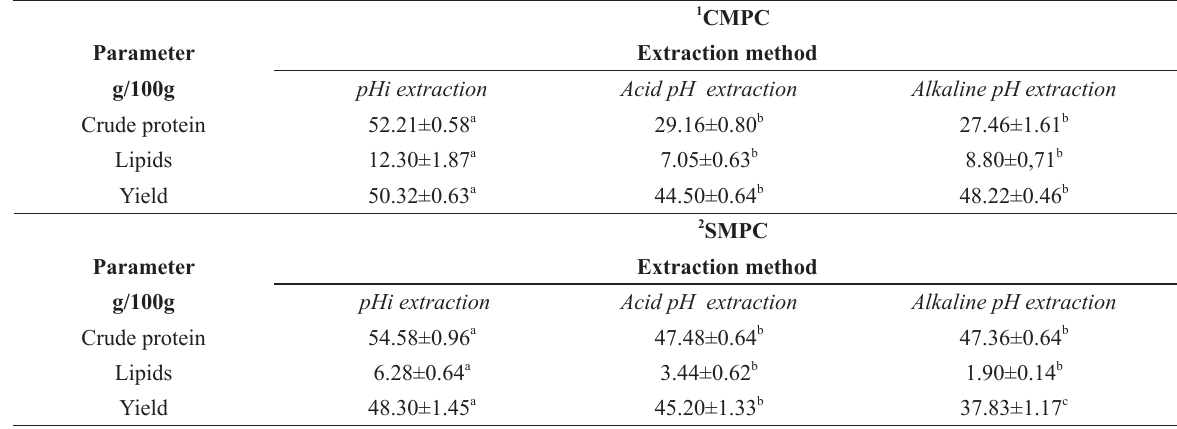
The protein and lipid compositions, as well as the percent yield relative to the meals, of the protein concentrates isolated from sunflower and crambe meals using three different extraction methods: isoelectric (pHi), acid pH and alkaline pH.